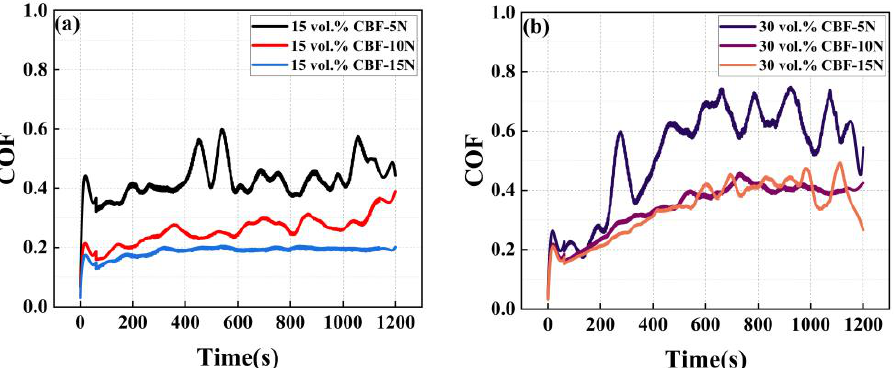
Figure 18. Friction coefficient test results of 15 vol.% and 30 vol.% basalt fiber composite coatings: ( a ) evolution of dynamic friction coefficient of 15 vol.% basalt content composite coating under different loads; ( b ) evolution of the coefficient of kinetic friction of 30 vol.% basalt content composite coating under different loads.